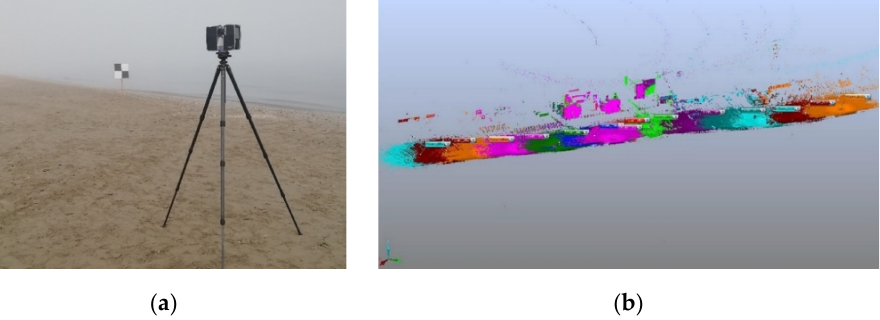
Figure 3. TLS survey at Riccione beach: ( a ) TLS with a target (chessboard on the backside); ( b ) raw-data scans, where each scan interval is identifiable by a different color.